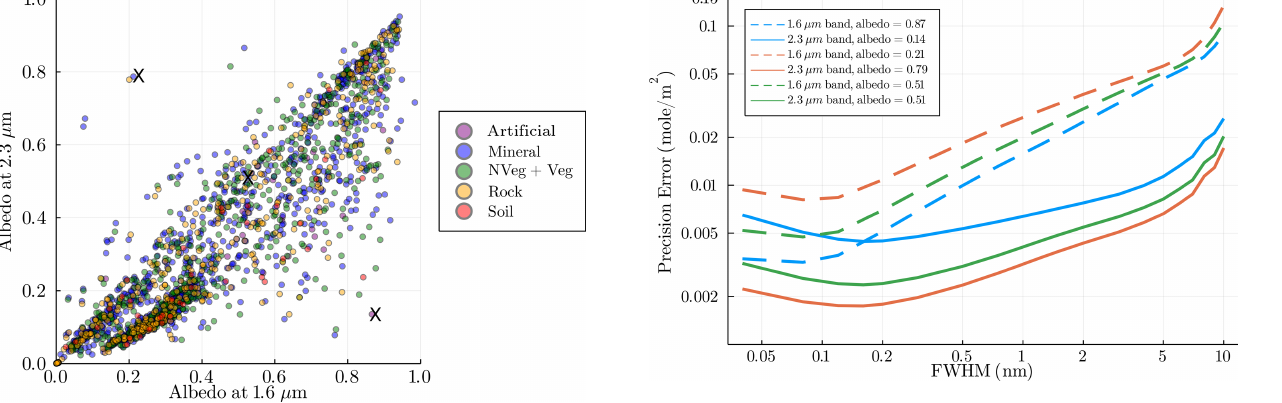
Figure 6. Scatterplot showing the relative values of reflectance at 1.6 vs. 2.3µm from our database of different surface albedos from the ECOSTRESS spectral library. Each point is a distinct surface, and the color shows the type to which it belongs. Cross marks rep- resent three example surfaces that we used in the comparison anal- yses.